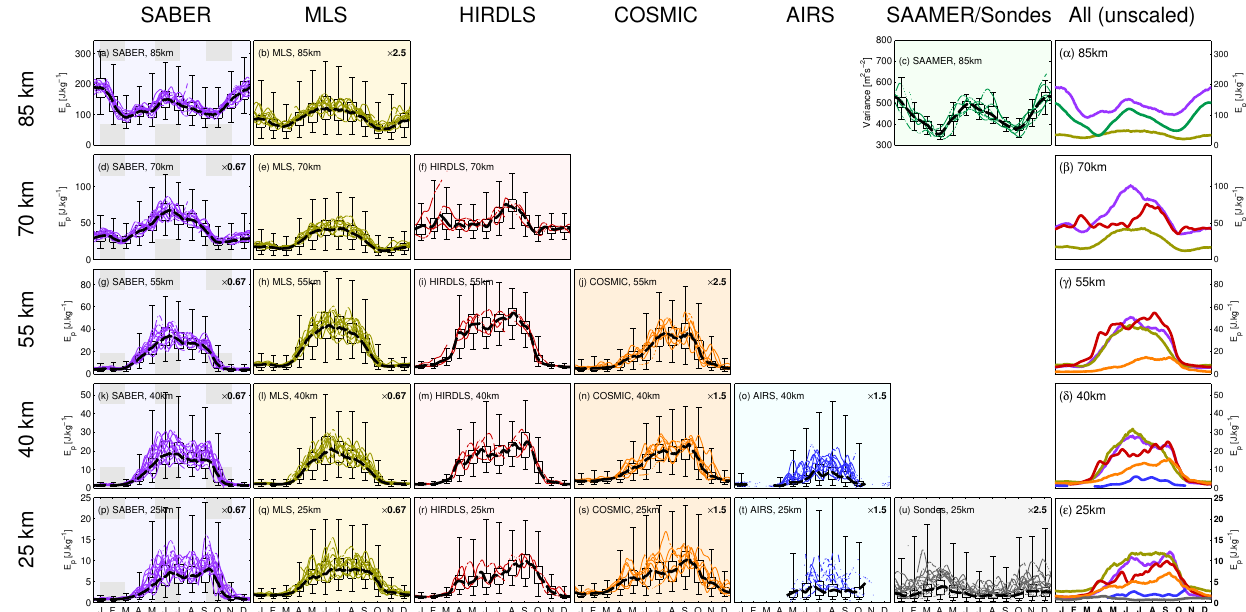
Figure 12. GWPE annual time series for each instrument at each valid height level. Each row of panels shows a single height level, and each column of panels shows the results for an individual instrument. Panels are only shown if data are present at that altitude for that instrument; AIRS and SAAMER share a column. For each panel, thinner lines show individual years, with the thicker black dashed line indicating the all-years